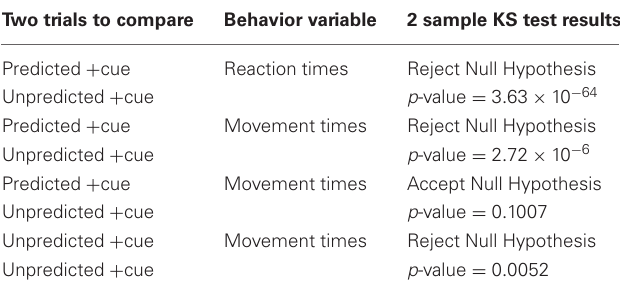
Table 2 | Results for 2 sample KS test for all possible trial pair